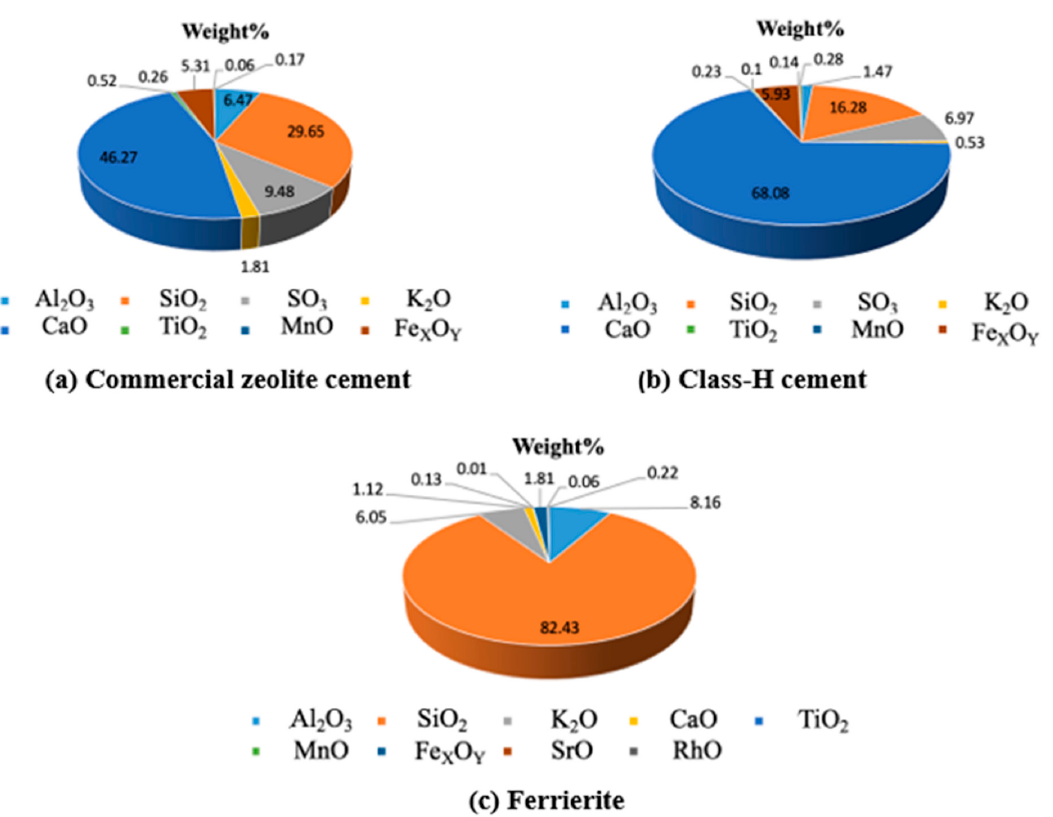
Figure 7. XRF results showing the percentage distribution of various oxides present in unhy- drated ( a ) commercial zeolite cement and ( b ) plain Class-H cement; ( c ) XRF data plot for ferrierite, which is a zeolite. The similarity in phases and or oxide compositions indicates that there are no new/intermediary phases that are formed. However, the addition of zeolite reduces the CaO content, which would eventually result in the more brittle phases of cement with hydration.